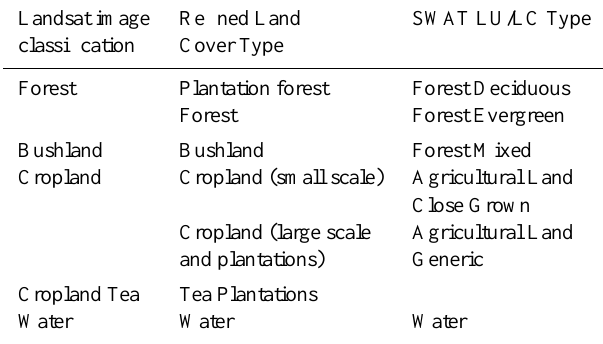
Table 2. Land use/land cover type reclassification into SWAT LU/LC